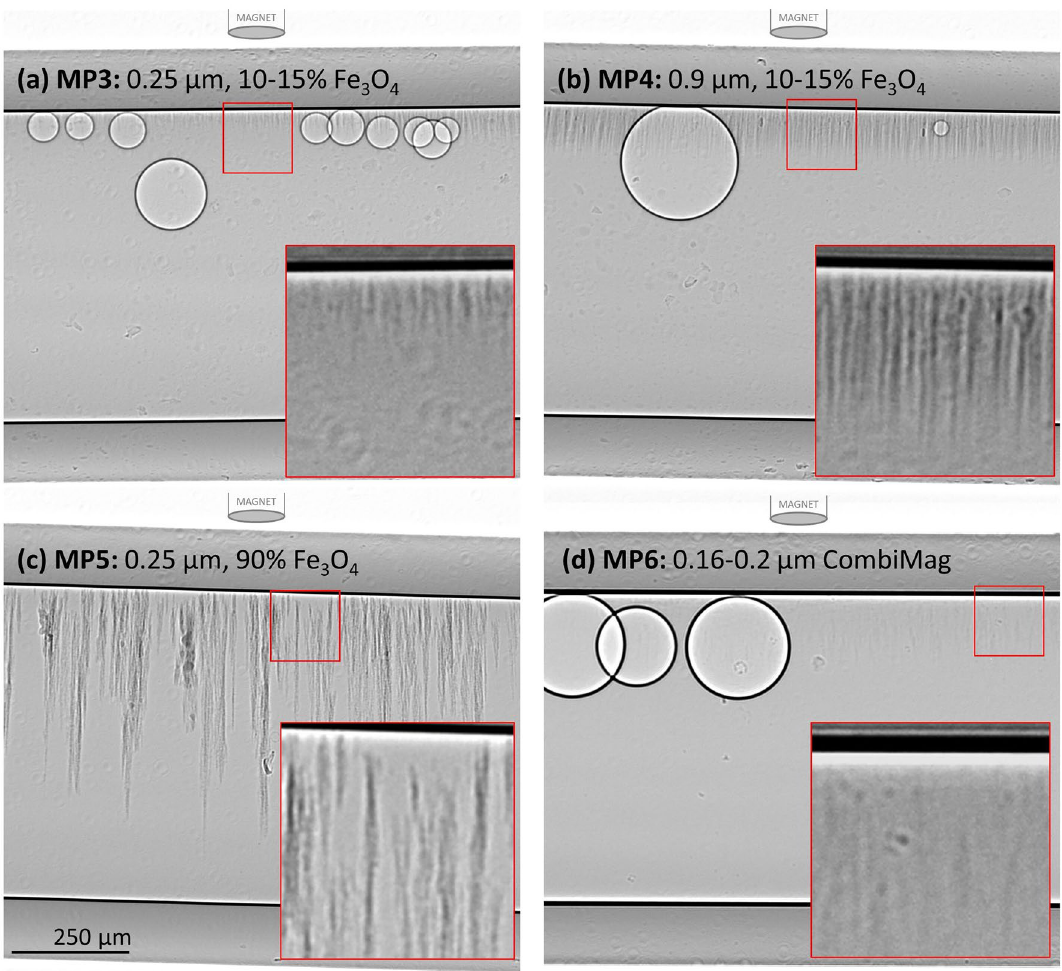
Figure 5. The visibility of the MP under PCXI varied markedly between the samples. ( a ) MP3, ( b ) MP4, ( c ) MP5 and ( d ) MP6. All images displayed here were taken with the magnet located ~ 10 mm directly above the capillary tube. The distinct large circular shapes are air bubbles trapped in the capillary tube, and clearly show the black-white edges characteristic of phase contrast imaging. Red boxes contain a contrast-enhanced enlargement. Note that the diameter of the magnet schematic in all Figures is not to scale and is ~ 100 × larger than